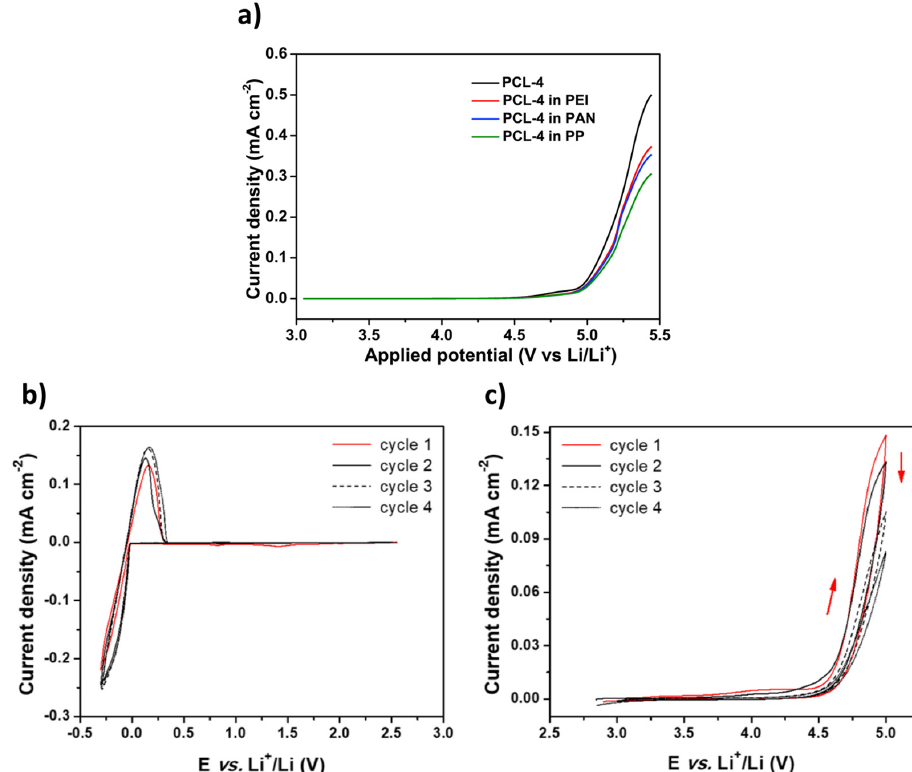
Figure 5. ( a ) Example of LSV profiles at 1 mV/s and 55 °C. Extracted with permission from ref [17].